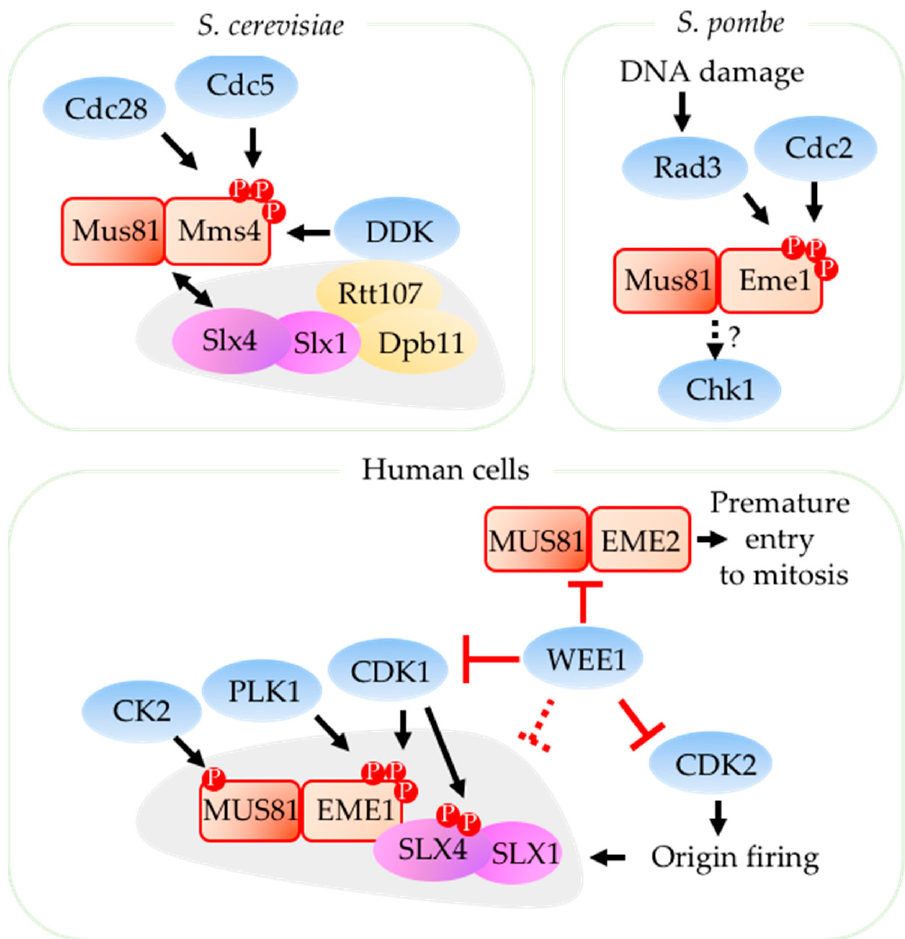
Figure 2. Mus81 regulation by cell cycle kinases. In S. cerevisiae , Mus81-Mms4 is phosphorylated by Cdc28 S.c. (CDK1 ortholog) and Cdc5 S.c. (PLK ortholog) kinases at the G2/M transition [48–50]. Scaffold protein Rtt107 S.c. (PTIP ortholog) associates with Dpb11 S.c. (TOPBP1 ortholog) and interacts with DDK which also phosphorylates Mms4 S.c. [52]. Rtt107-Dpb11-Slx4 S.c. complex associates with Mus81- Mms4 S.c. behind replication forks. In S. pombe , Mus81-Eme1 S.p. is phosphorylated by Cdc2 S.p. (CDK1